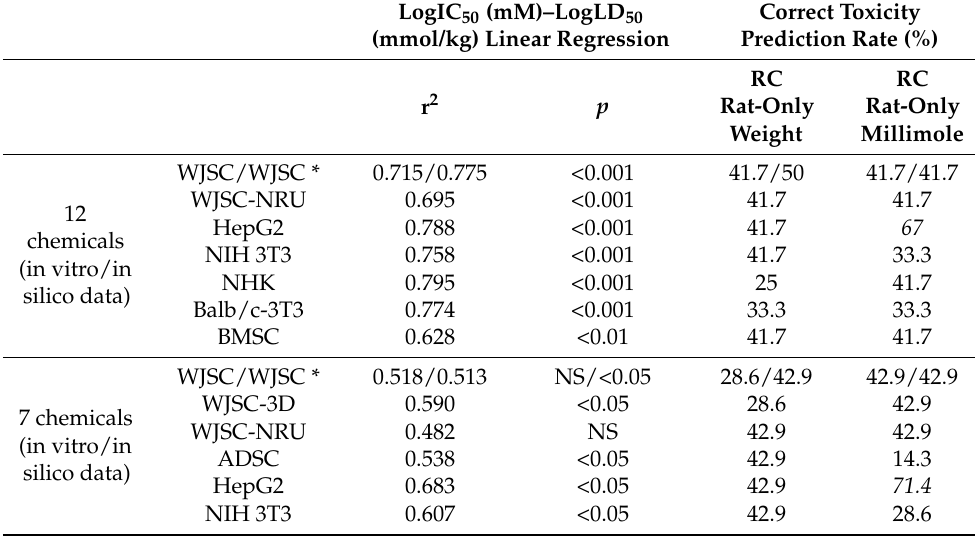
Figure 3. Comparison of linear regressions of WJSCs with human and murine cell lines after 48 h of treatment with the 12 selected chemicals: ( a , c ) In vitro comparison with NIH 3T3 (solid line, open squares) and HepG2 cells (dashed line, closed triangles). Data were obtained by means of the MTS assay. Regression equations, r 2 , and p -values were generated and used to compare predictability of the assays. ( b , d ) In silico comparison with BALB/c 3T3 (solid line, open squares) and NHK cells (dashed line, closed triangles). Data for WJSCs were obtained via the NRU method in our lab, while data for BALB/c 3T3 and NHK cells, and the respective LD 50 values, were derived from the ICCVAM validation study [6]. The WJSC regression line is represented in both analyses by a dotted line with data points marked as “x” symbols. Regression equation, r 2 , and p -values were generated and used to compare the predictability of the assays. Table 4. Summary of toxicity assay performances.